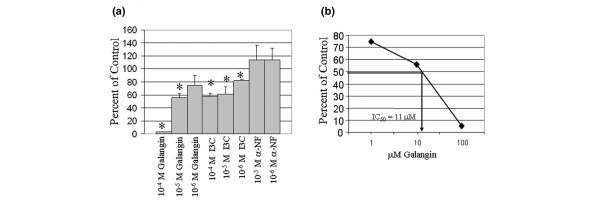
Galangin inhibits proliferation of Hs578T breast cancer cells. Hs578T cells were treated in triplicate with vehicle, 10-4 to 10-6 M galangin, 10-4 to 10-6 M indole 3-carbinol (I3C), or 10-5-10-6 M α-naphthoflavone (α-NF) and grown in 3H-thymidine-containing media for 18 hours. Triplicates were averaged for each point in each experiment. (a) Data are pooled from 3 to 11 experiments and presented as the percent of control (vehicle-treated) counts per minute (CPM) + standard error. In 11 experiments, the average CPM in vehicle-treated controls was 35,583 + 6,893. An asterisk (*) indicates a significant decrease in 3H-thymidine incorporation relative to vehicle controls, p < 0.05. (b) Data obtained with galangin as above were replotted to determine the IC50 (median inhibition concentration) (median inhibition concentration). The calculated IC50 was 11 μM.